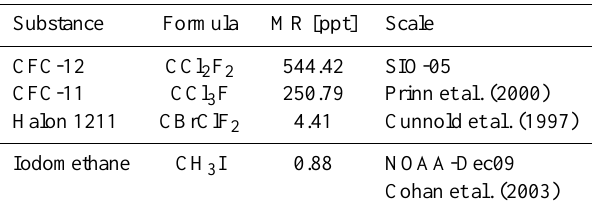
Table 1. Mixing ratios in ppt in the reference gas used in this work for the discussed